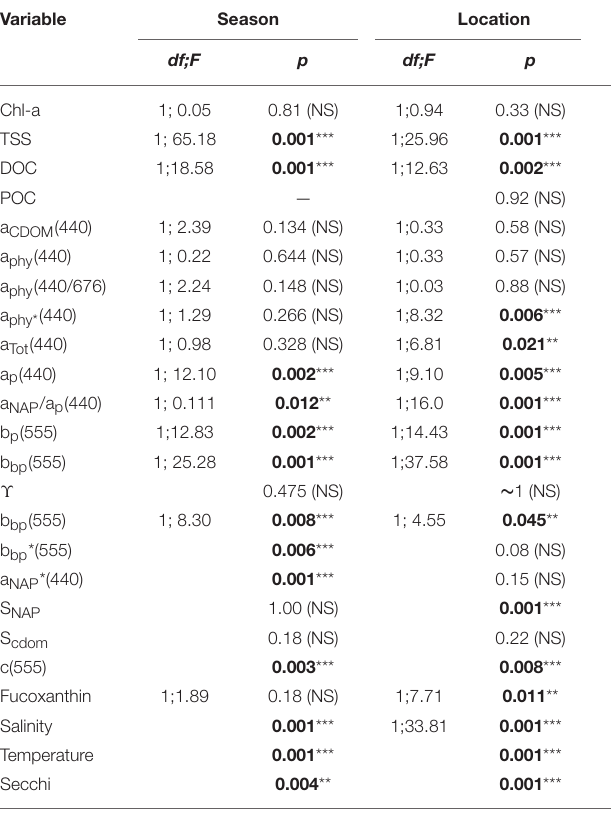
TABLE 3 | One-way ANOVA results for selected concentrations, IOPs and metadata. The factor “Season” refers to dry vs. wet seasons (Van Diemen Gulf stations only), and “Location” refers to Van Diemen Gulf vs. Darwin Harbour (during the dry season